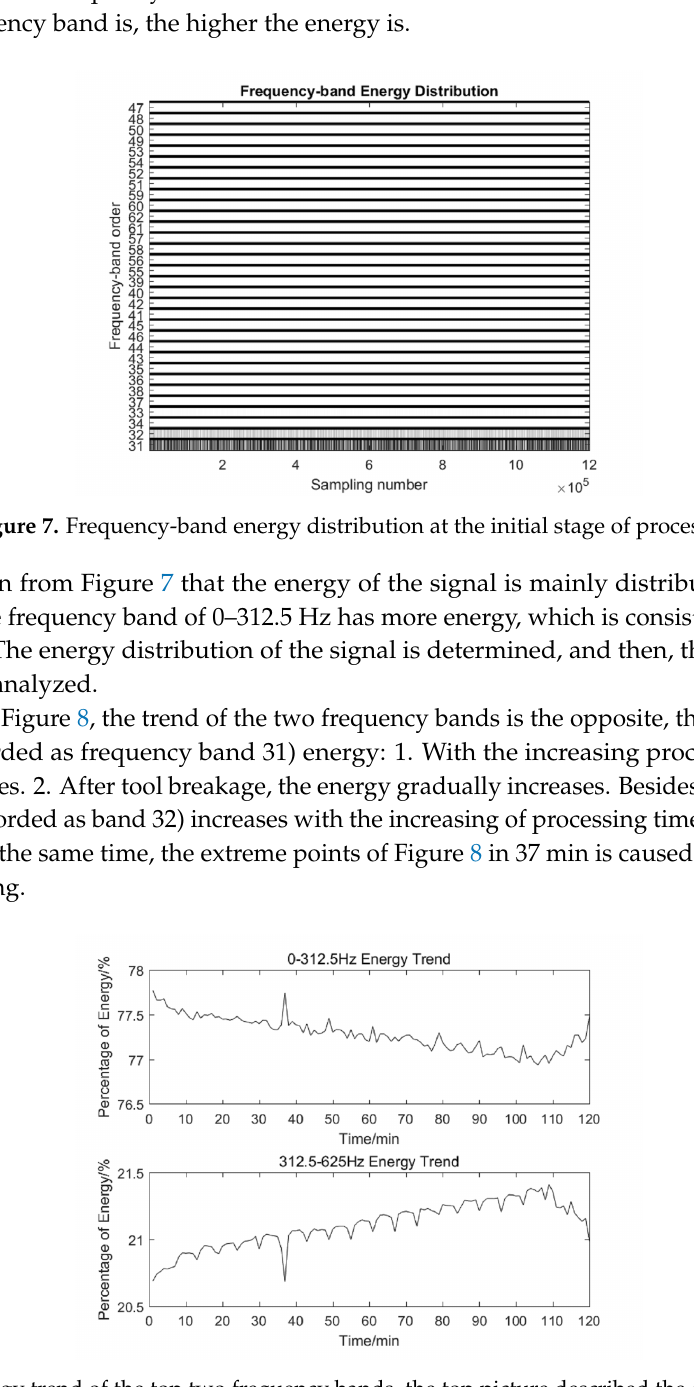
Figure 8. Energy trend of the top two frequency bands, the top picture described the energy change of the band 0–312.5 Hz, the bottom picture indicated the energy change of the band 312.5–625